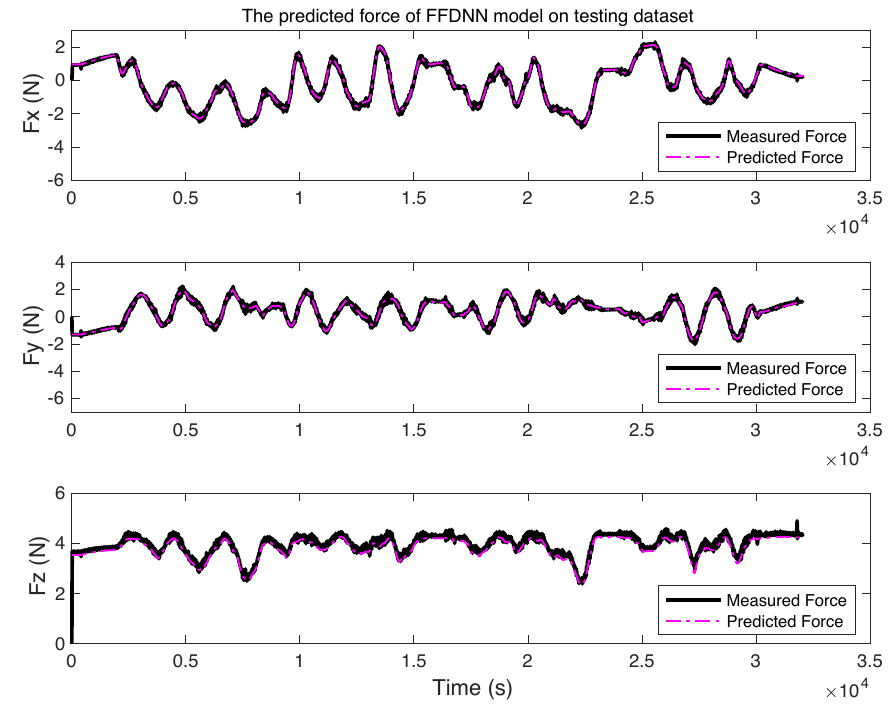
Figure 12. The predicted force of M2 model on the testing